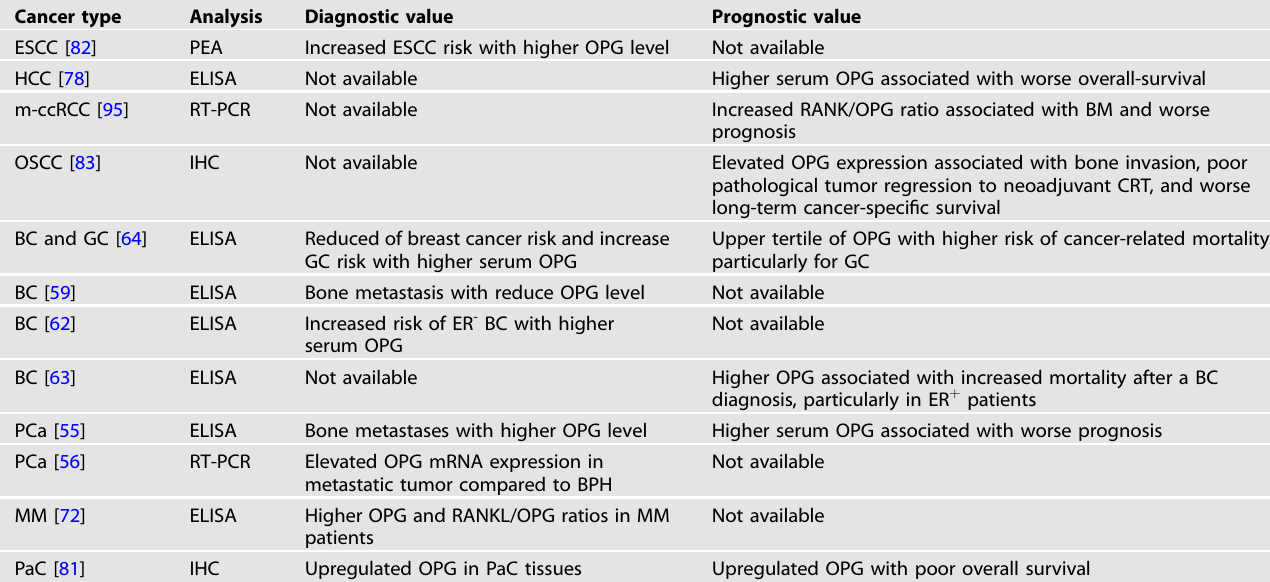
Table 1. A glance of clinical signi fi cance of OPG in